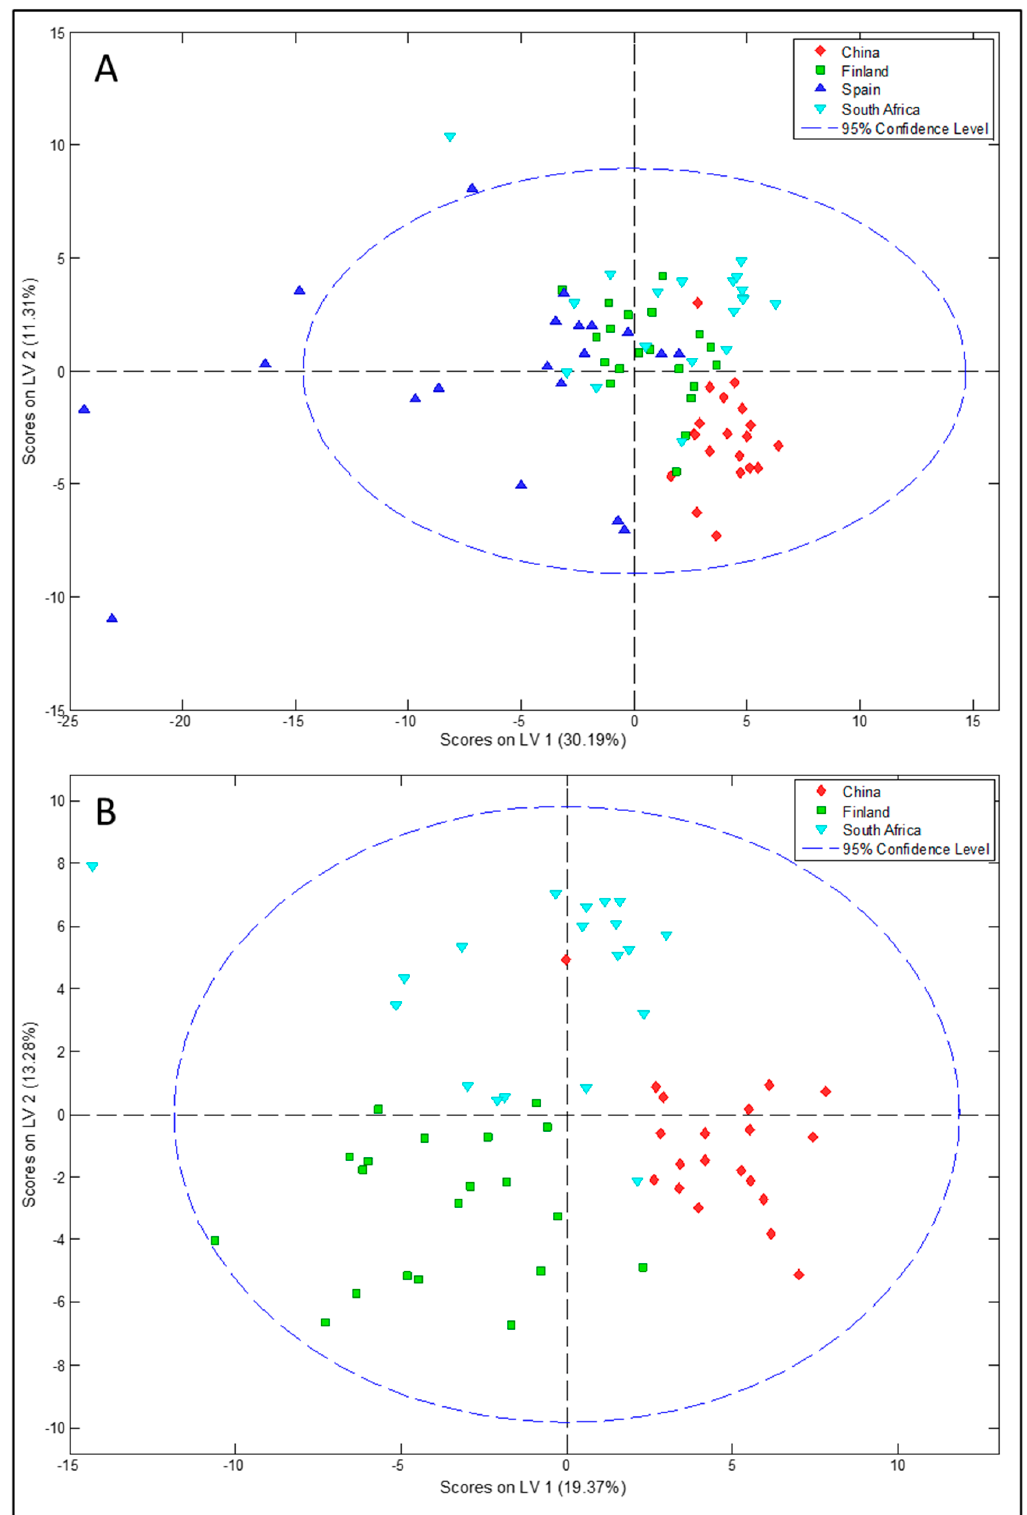
Figure 1. Partial least squares discriminant analysis (PLSDA) scores plot scaling nuclear magnetic resonance (NMR) data from all participant countries ( A ); participant countries without Spain ( B ). Countries are indicated as red diamonds (China), green squares (Finland), navy blue triangles (Spain), pale blue triangles (South Africa).